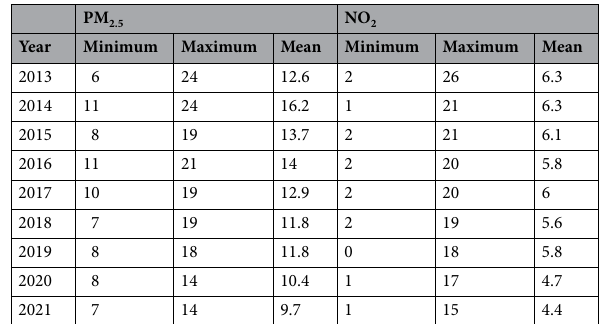
Table 2. Annual descriptive statistics for PM 2.5 and NO 2